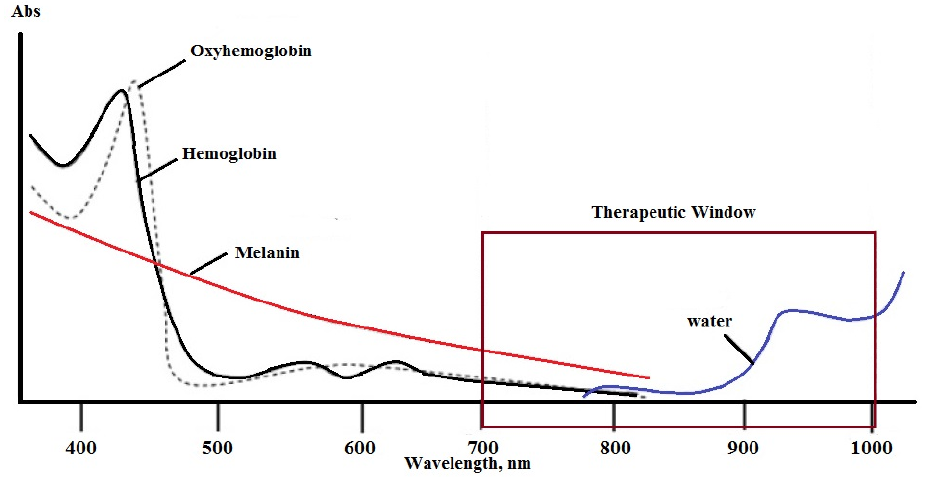
Figure 3. Illustration of the therapeutic window for PDT treatment.